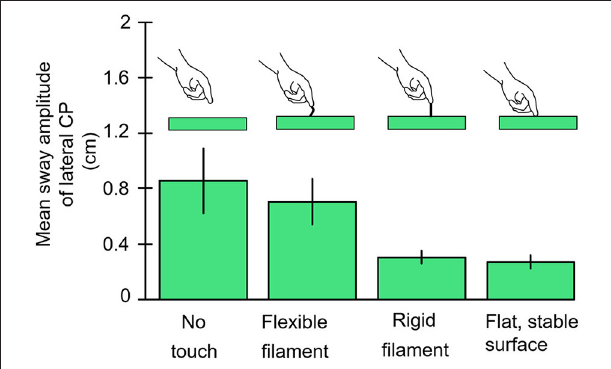
FIGURE 4 | The results are illustrated for the no-contact, von Frey Filament with 10g bending resistance, rigid metal filament, and light-touch finger conditions. The von Frey filaments with larger bending constants are not shown but all attenuate sway more than the 10g filament. The rigid filament and finger touch attenuate CP mean sway amplitude more than other conditions.